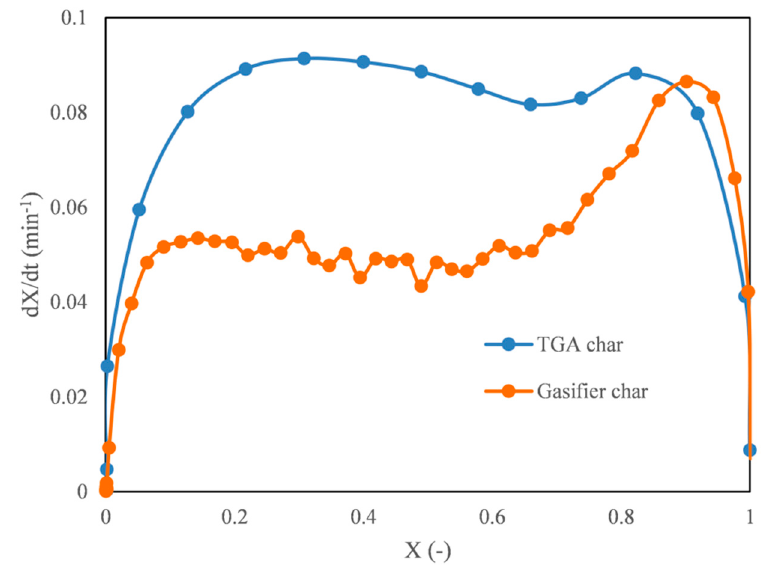
Figure 1. Reactivity of thermogravimetric analysis (TGA)-derived char as compared to the gasifier- derived char.